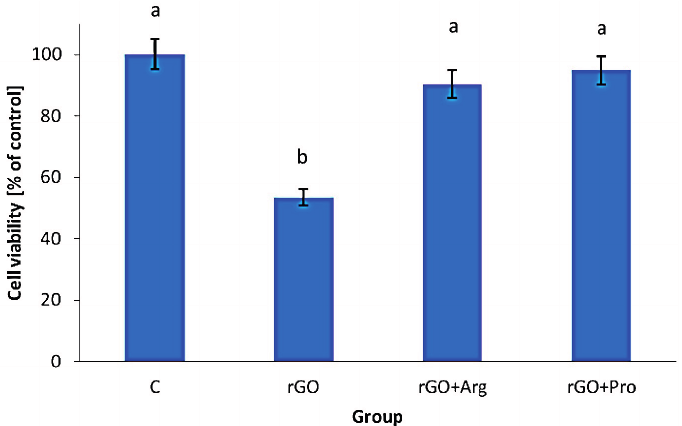
Figure 5. Effect of reduced graphene oxide, reduced graphene oxide with arginine, and reduced graphene oxide with proline on the viability of U87 glioblastoma cells. Notes: Bars with different superscripts indicate significant differences between groups ( p < 0.05); error bars are standard deviations. C: control group (untreated cells); rGO: reduced graphene oxide; rGO + Arg: reduced graphene oxide with arginine; rGO + Pro: reduced graphene oxide with